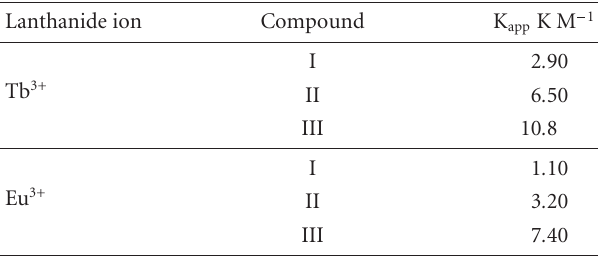
Table 1: Estimation of apparent formation constant of Tb 3+ and Eu 3+ in the presence of I,II, and III using Benesi-Hildebrand plot in methanol at 25 Æ C.